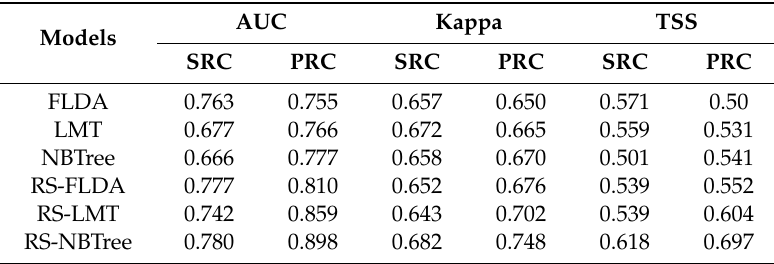
Table 6. Validation of Results.